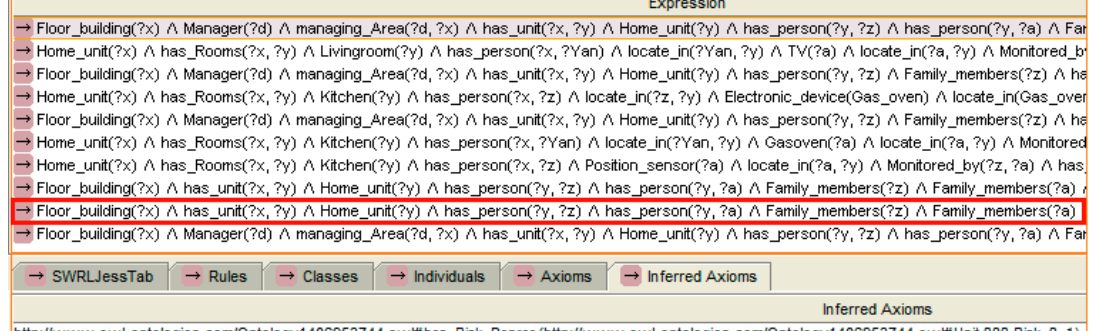
Figure 22. The rule selected and reasoning result of the risk update.